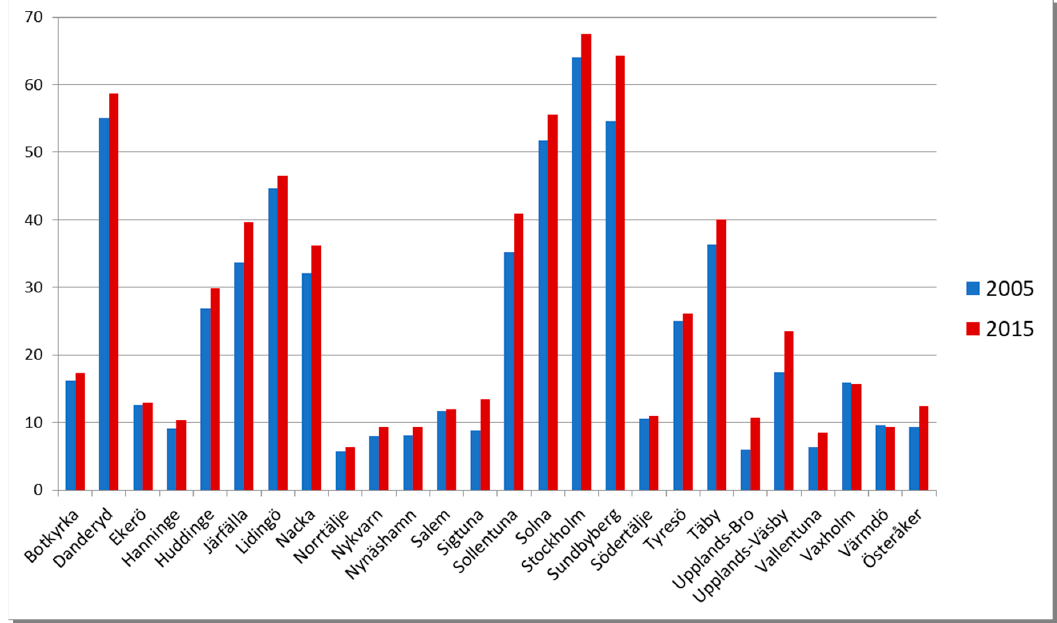
Figure 5. Change in urban land area percentage per municipality in Stockholm County between 2005 and 2015.